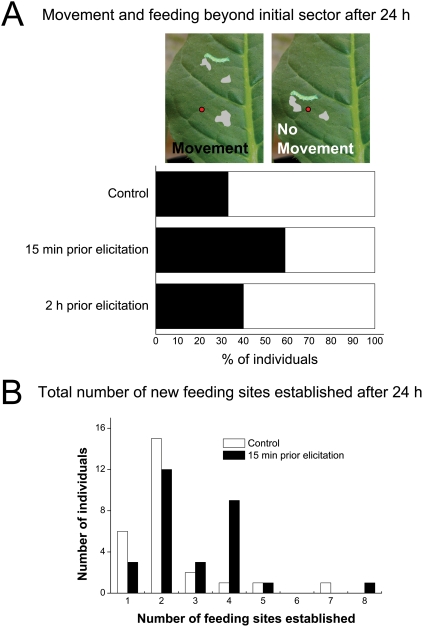
OS-elicitation motivates movement of M. sexta larvae away from elicited laminal sectors.1st instar M. sexta were placed on the underside of N. attenuata leaf sectors that were (1) un-elicited (control), or elicited (2) 15 min or (3) 2 h prior to placement of caterpillars. Movement and feeding activity of larvae between and within sectors were recorded. (A) 24 h after elicitation, a larger percentage of larvae had moved to a new laminal sector (solid bars) if the leaf had been elicited 15 min prior to placement (17 of 29 larvae) than if the leaf was un-elicited (9 of 27 larvae; pair-wise χ2 = 3.60, P = 0.06). However, if leaves were elicited 2 h prior, larval movement did not differ from that on control leaves (10 of 25 larvae moved to a new laminal sector). (B) Comparison of the total number of feeding sites established by individuals on control leaves (open bars) and leaves elicited 15 min prior to larval placement (solid bars) revealed that prior OS elicitation motivated larvae to initiate additional feeding sites on elicited leaves.